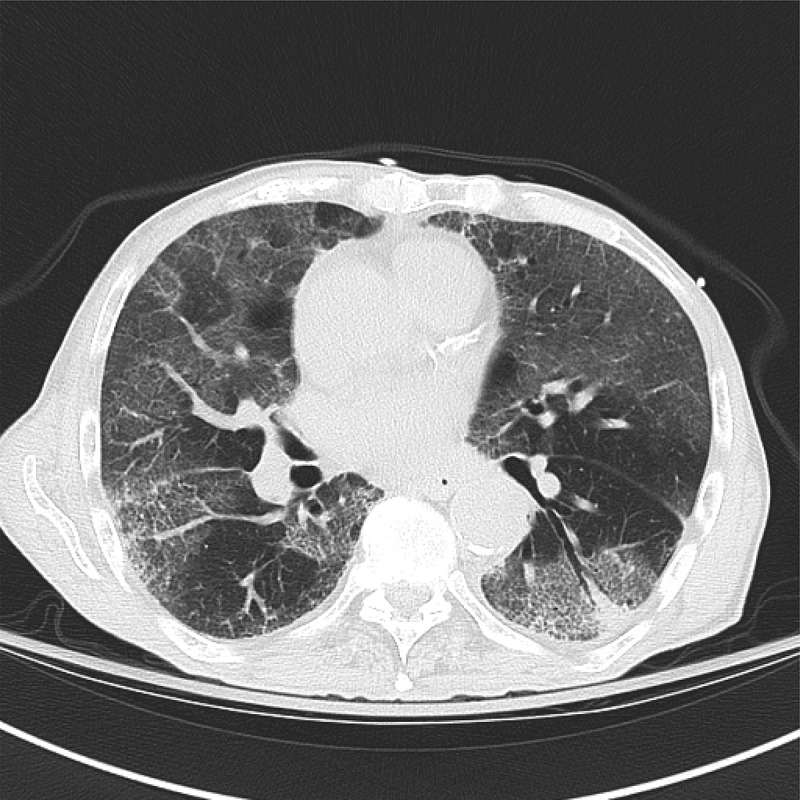
CT scan of chest showing bilateral diffuse ground glass opacity of lung parenchyma on presentation.